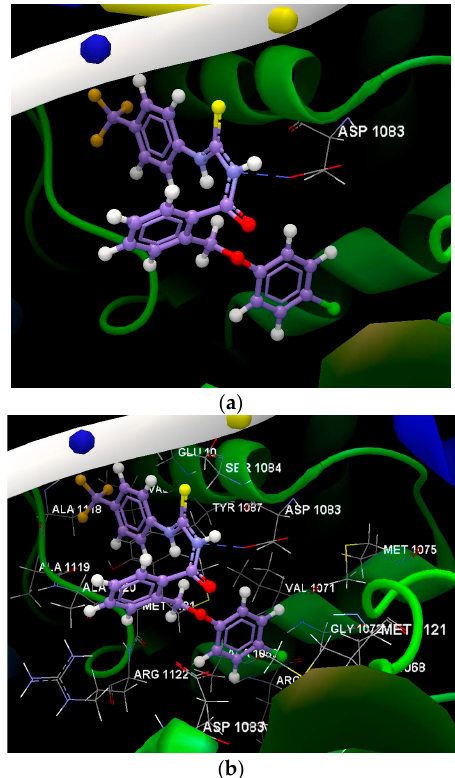
Figure 6. ( a ) The hydrogen bond between the amino acid residue of the ASP 1083(D) and the compound 1g was displayed in dashed lines. ( b ) Docking pose of the 1g ligand interacting with amino acids residues.